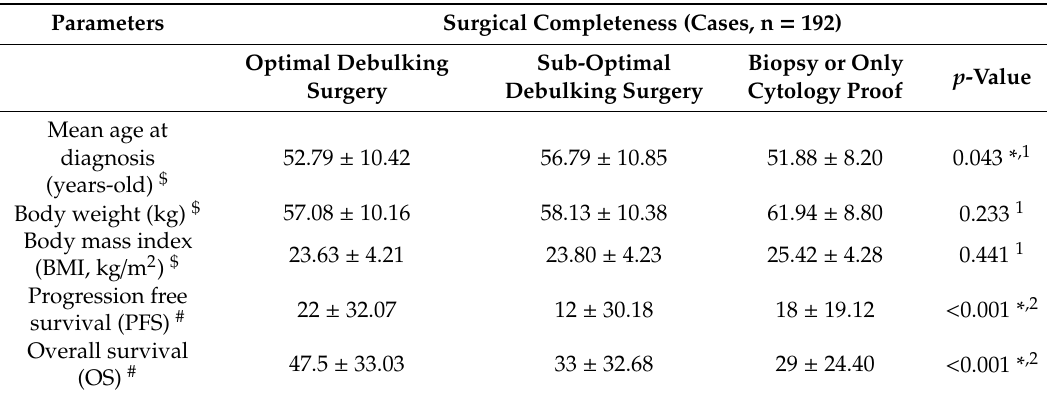
Table 3. Case summaries according to surgical completeness.